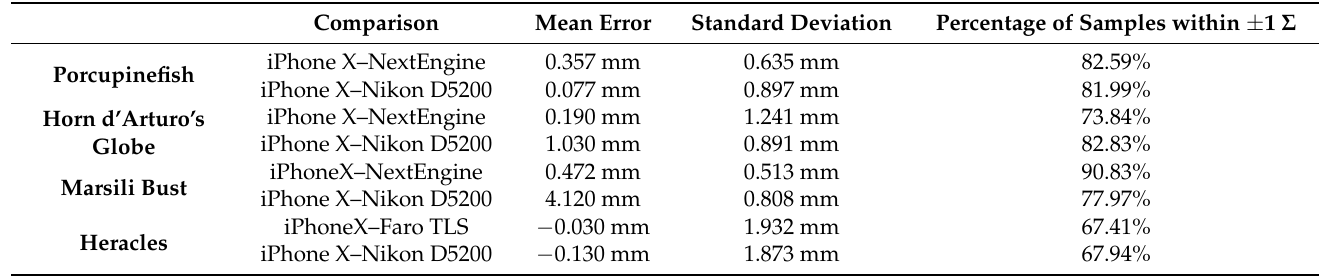
Table 12. iPhone X vs. Ground truth models comparison.